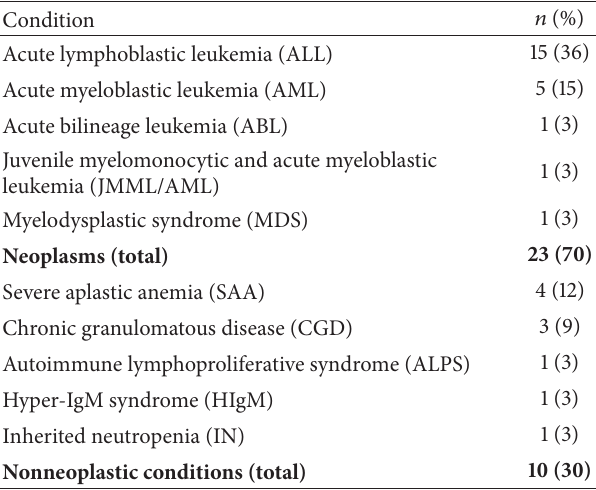
Table 1: The indications for HSCT (pre-HSCT group). Table 2: Characteristics of studied groups.